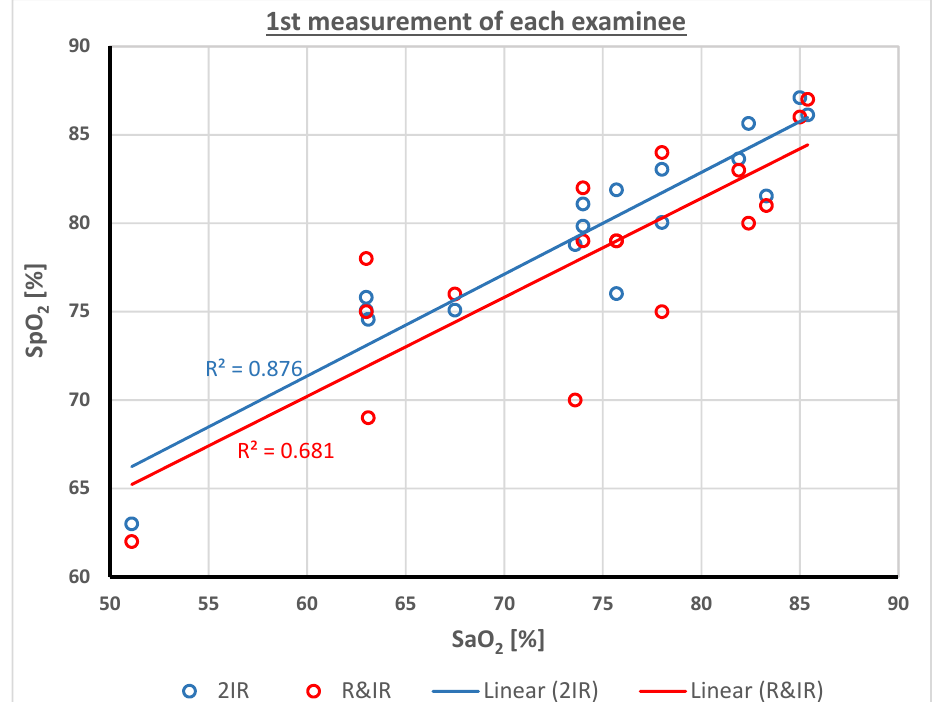
Figure 3. SpO 2 readings as a function of SaO 2 for SpO 2 _R-IR (red circles) and SpO 2 _2IR (blue circles). The lines are the respective regression lines.